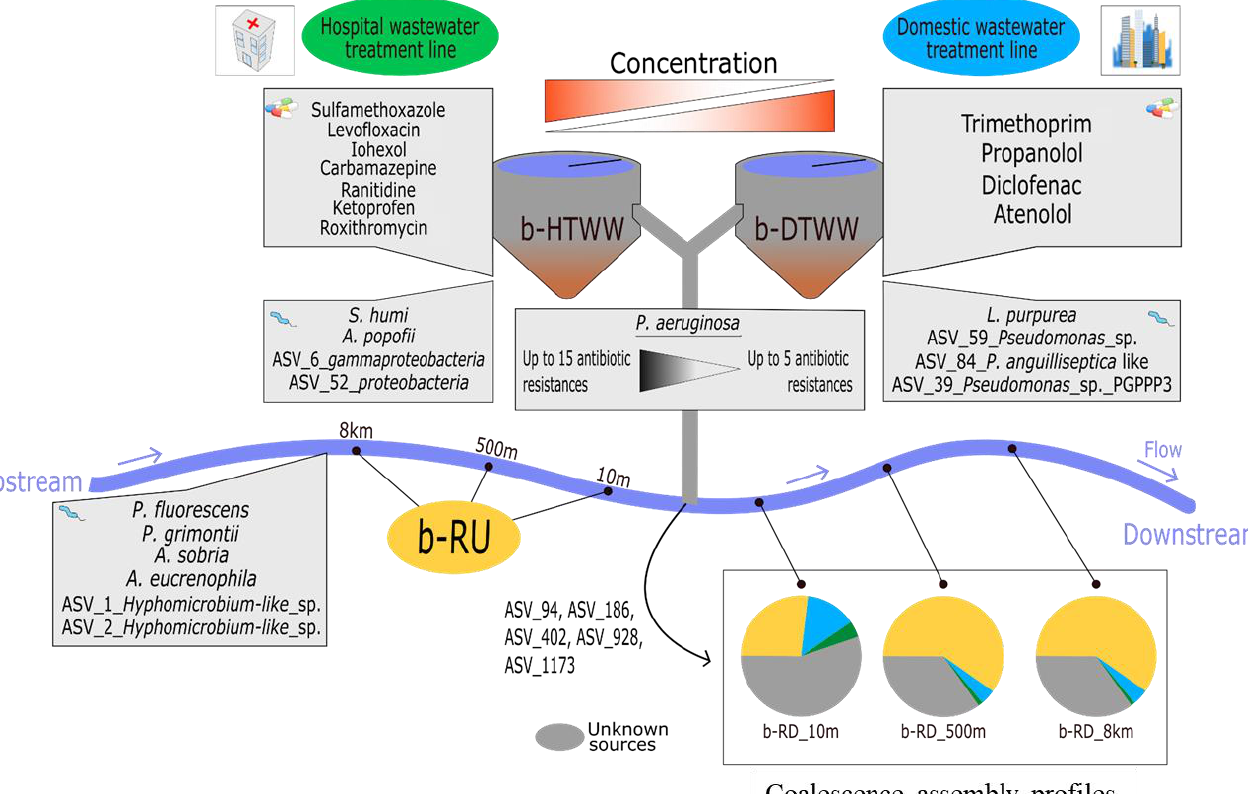
Figure 4. Illustration and overview of the main results observed during this study. Specific pharma- ceuticals, tpm ASV, and inferred species from b-HTWW, b-DTWW, and river biofilms are indicated according respectively to Figure 1 and Tables S7 and S8. The coalescence of the tpm ASV from the b-TWW samples among the river biofilm samples are indicated according to Table 1. Color codes differentiate the compartments investigated in this study.